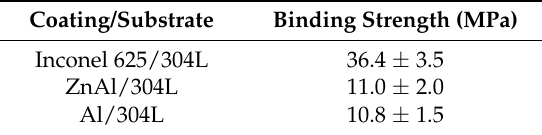
Table 3. Adhesion test for the thermal spray coatings.